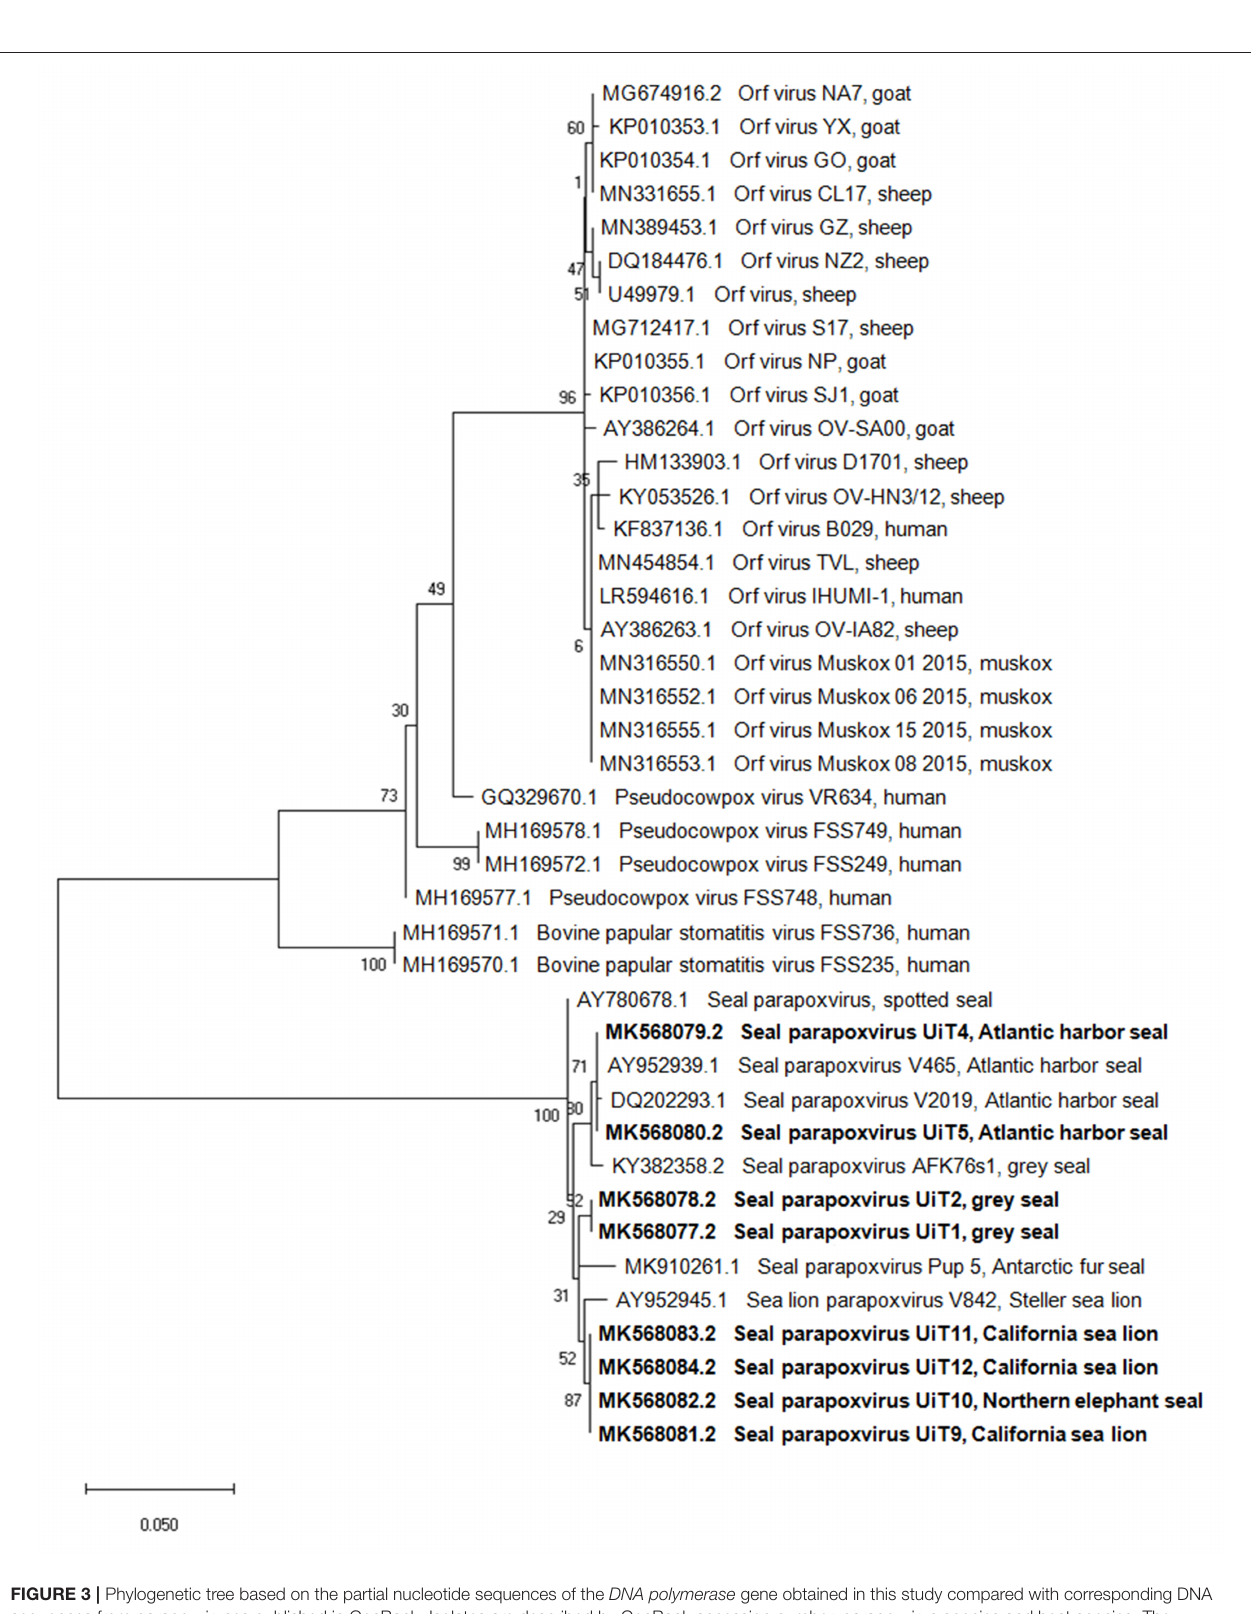
Frontiers in Veterinary Science |